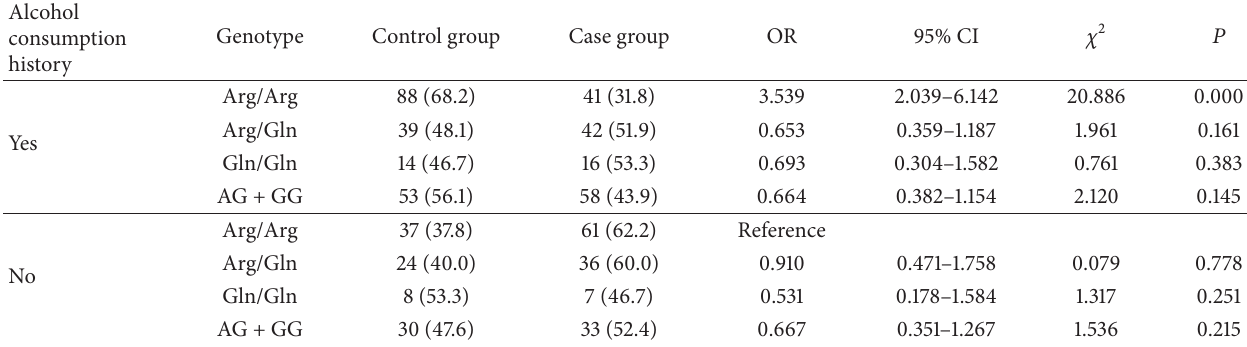
Table 3: The interaction between alcohol consumption history and XRCC1 Arg399Gln polymorphism ( 𝑛